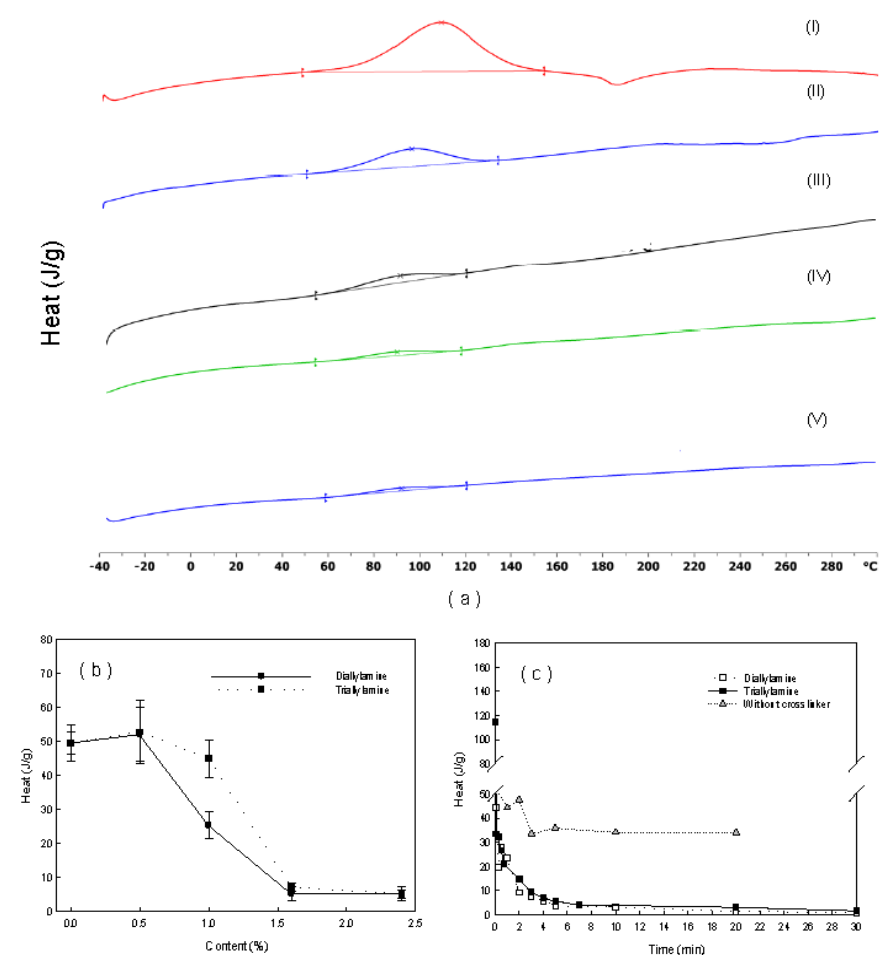
Figure 6. ( a ) DSC thermograms of pellets prepared with different concentrations of crosslinker (I: 0%, II:0.5%, III: 1.0%, IV: 1.6%, V: 2.4%), ( b ) area of curing peaks relative to amount of different concentrations of crosslinker with chemical initiator, and ( c ) area of curing peaks relative to UV exposure time with photoinitiator. Int. J. Environ. Res. Public Health 2020 , 17 , x